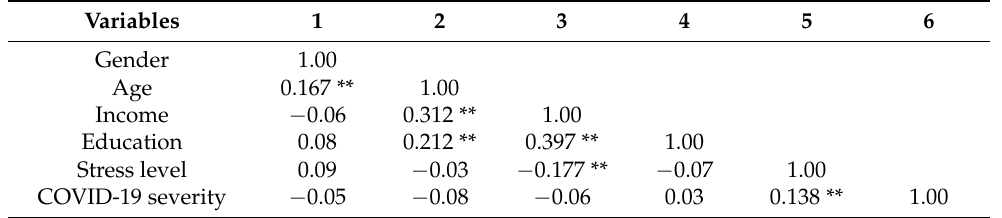
Table 1. Correlation matrix of